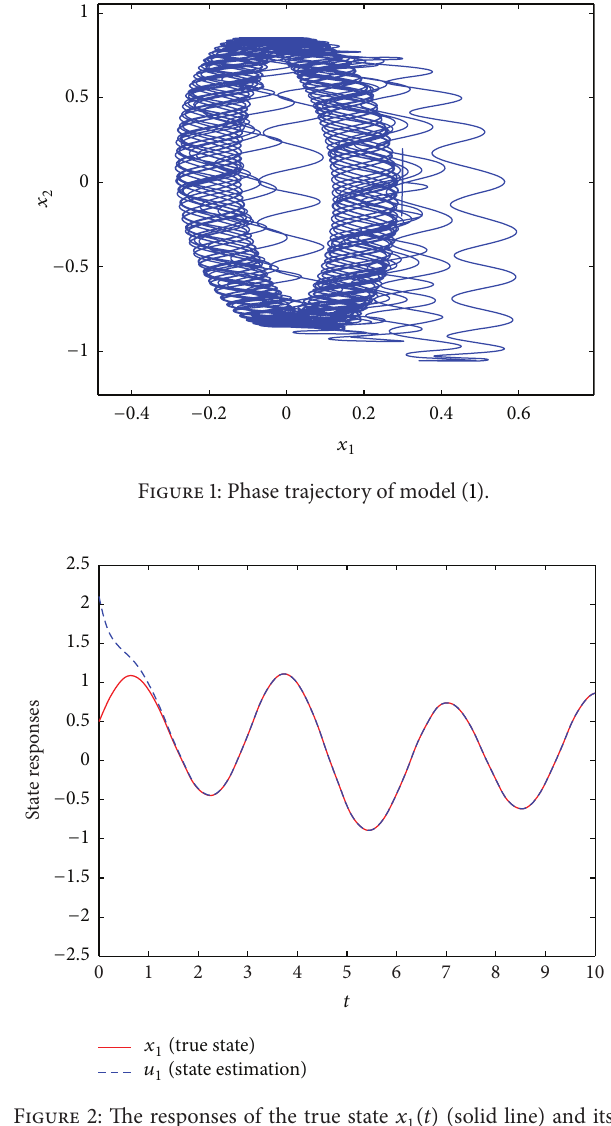
Figure 2: The responses of the true state 𝑥 1 (𝑡) (solid line) and its estimation 𝑢 1 (𝑡) (dash line).